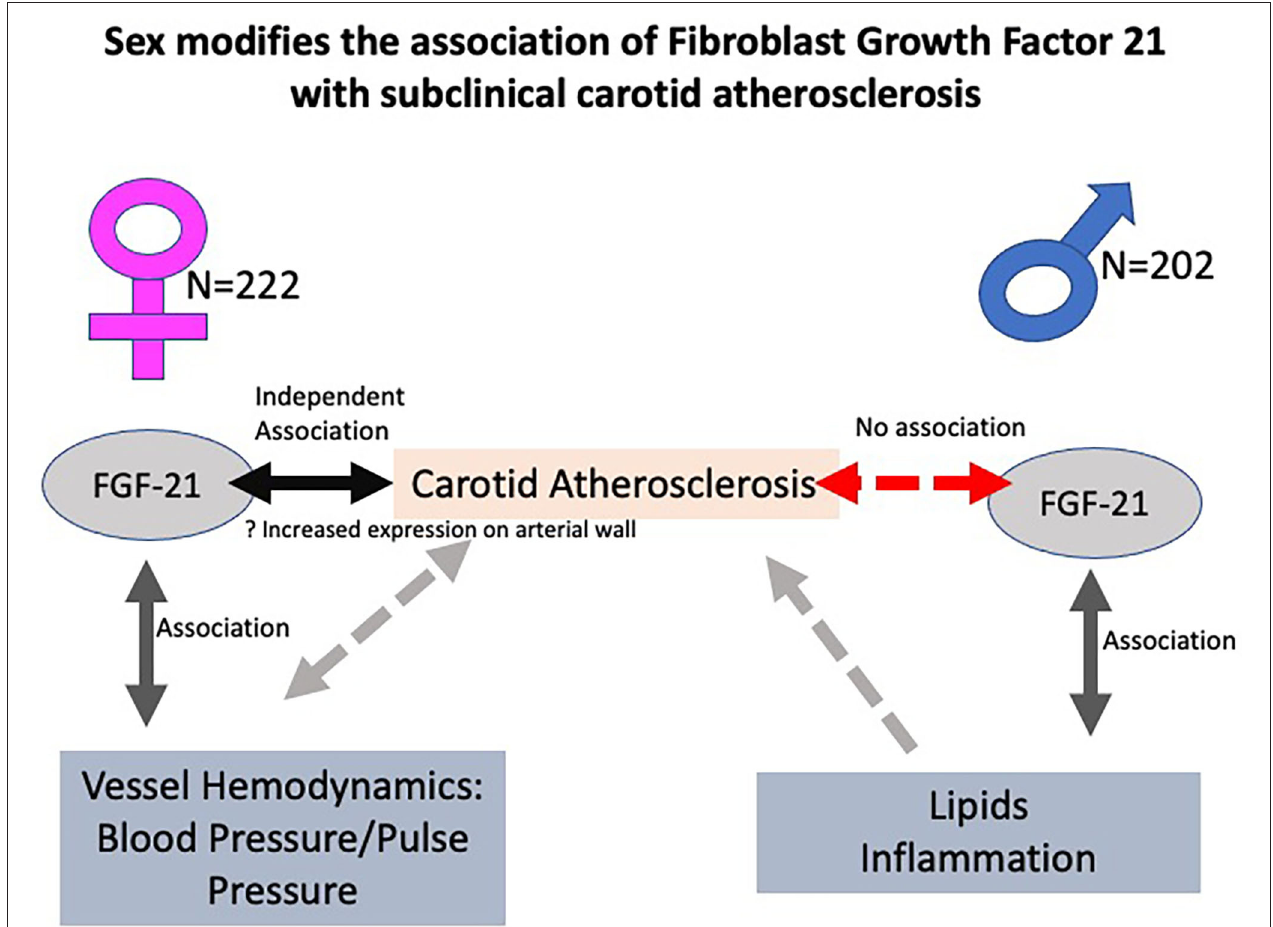
FIGURE 4 | Central illustration showing the sex interactions in the relationship between fibroblast growth factor 21 (FGF21) and carotid atherosclerosis with postulated mechanisms. FGF21 is positively associated with subclinical carotid atherosclerosis in women but not in men. A postulated hypothesis is that a downstream signaling of FGF21 on vascular hemodynamics like blood pressure and vascular stiffness is likely responsible for this effect in women. In men, likely FGF21 affects inflammation and lipids, which is known to cause